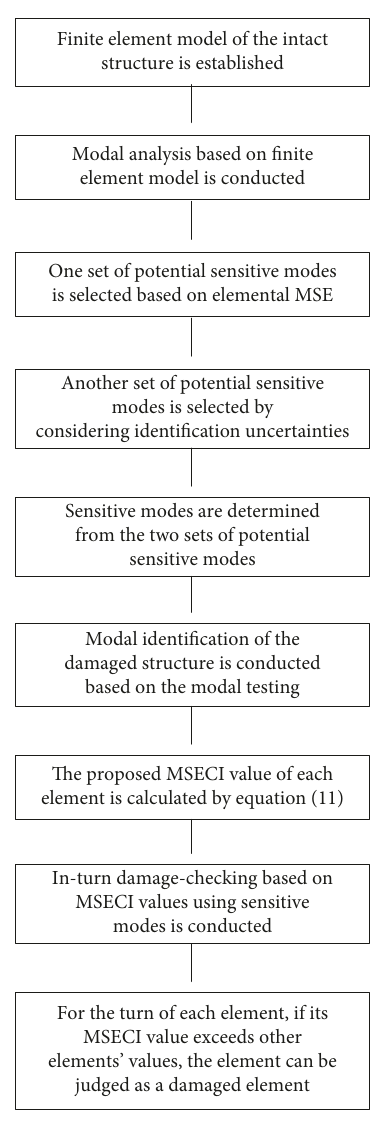
Figure 1: The flow chart of the proposed MSECI